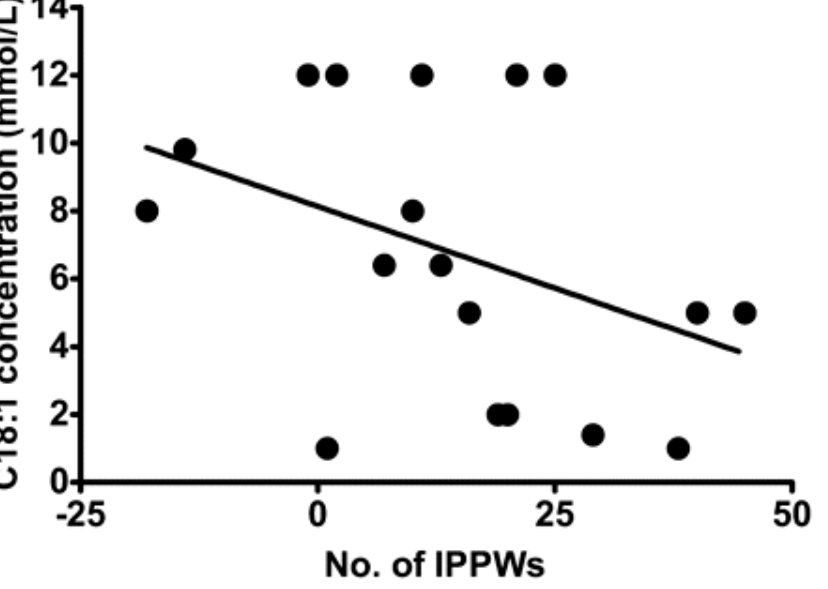
Figure 2. Relation between oral detection thresholds for oleic acid (18:1) and total number of isolated pyloric pressure waves (IPPWs) during 90-min intraduodenal infusions (0.78 kcal/min) of saline and oleic acid (18:1) in lean ( n = 8) and overweight or obese ( n = 11) subjects. Taken from